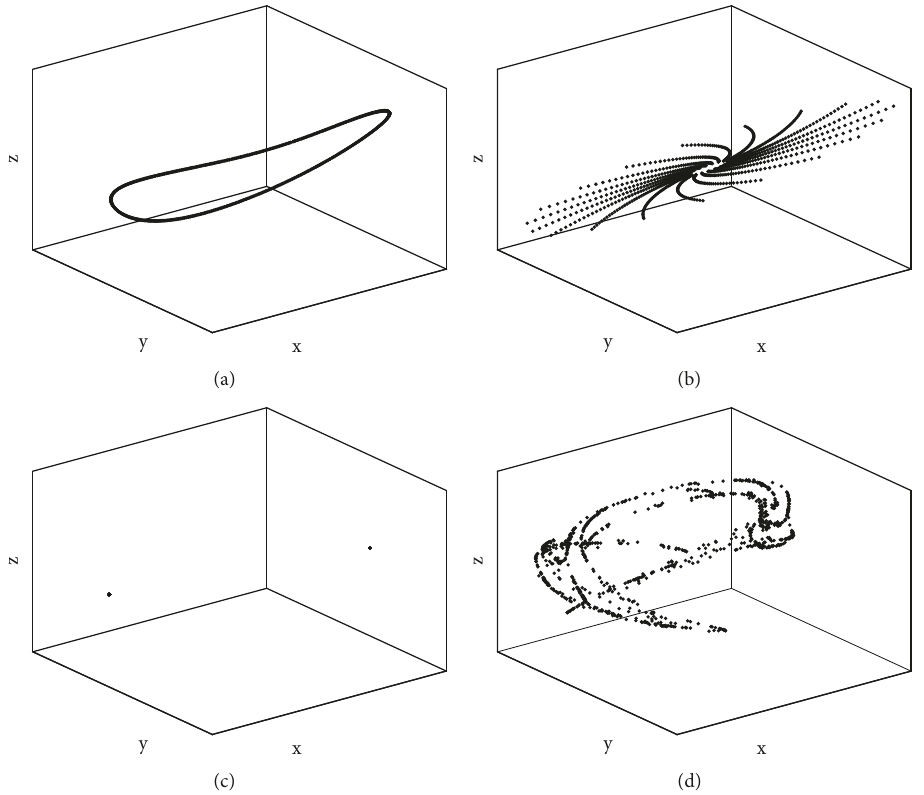
Figure 8: (a) An invariant curve in 3 -space in case of 𝐻 small. Parameter values (𝐹,𝐺, 𝐻) = (43,5, 1.3) . (b) Convergence towards the stable equilibrium (𝑥 ∗ , 𝑦 ∗ ,𝑧 ∗ ) . Parameter values (𝐹,𝐺, 𝐻) = (43, 5, 1.32) . (c) A 2 cycle generated by model (27). Parameter values (𝐹, 𝐺,𝐻) = (43,5, 1.64) . (d) Chaotic dynamics. Parameter values (𝐹,𝐺, 𝐻) = (43,5,2.38) .